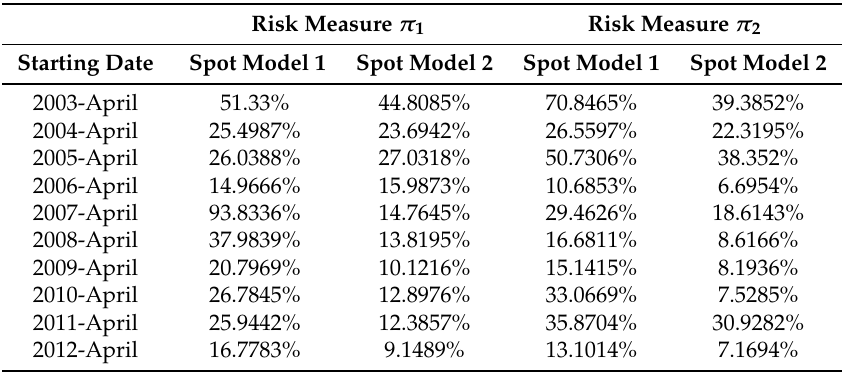
Table 7. Model risk measure for spot models 1 and 2. All figures are in million